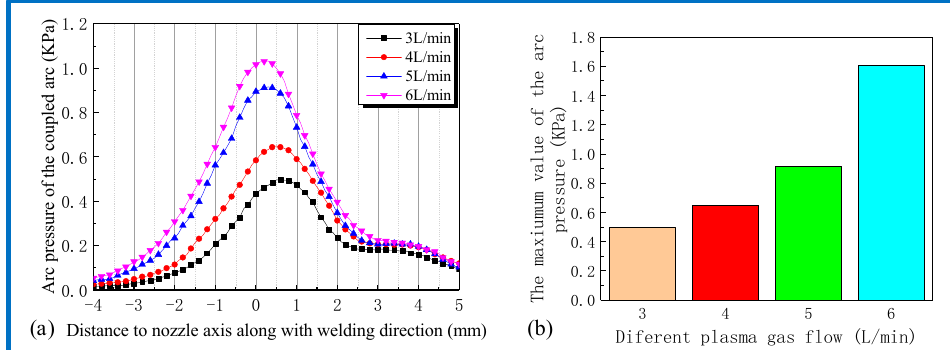
Figure 12. Coupled arc pressure with different plasma gas flow. ( a ) coupled arc pressure along with welding direction. ( b ) Max value of coupled arc pressure.